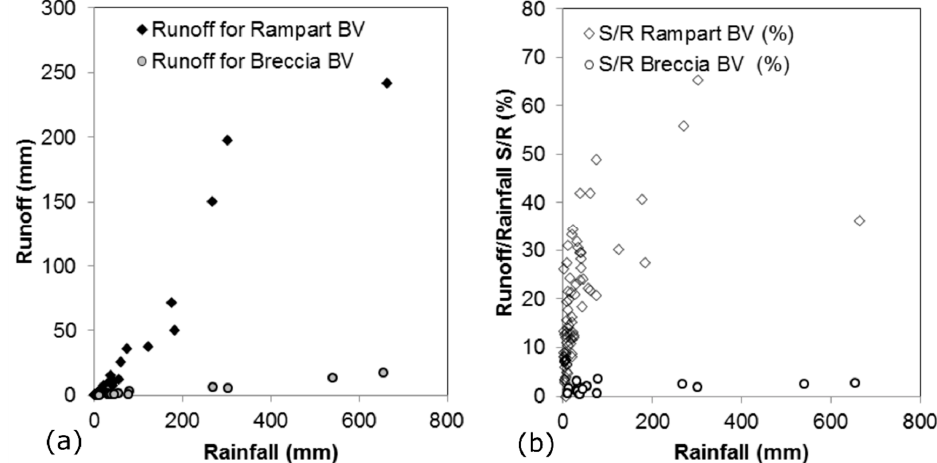
Figure 10. Rainfall/runoff relationship by event ( a ) for the breccia watershed at the Clain (S6) station and ( b ) for the rampart watershed at the Ravine Blanche (S1) station for the 2011 and 2012 hydrologic cycles. Quantified runoff coefficients are ten times greater over the rampart watershed than over the breccia one.